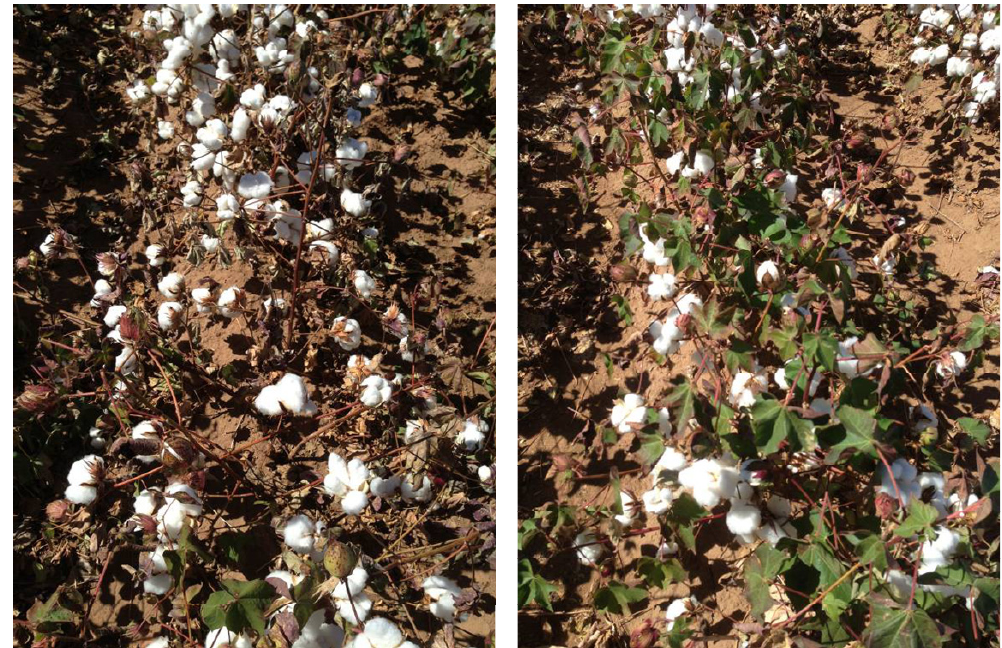
Figure 13. Cotton plants in left frame were naturally defoliated by triggering early senescence by main stem girdling. Cotton plants in the right frame were the control plants that were untreated (pictures taken on same day and were in neighboring rows).